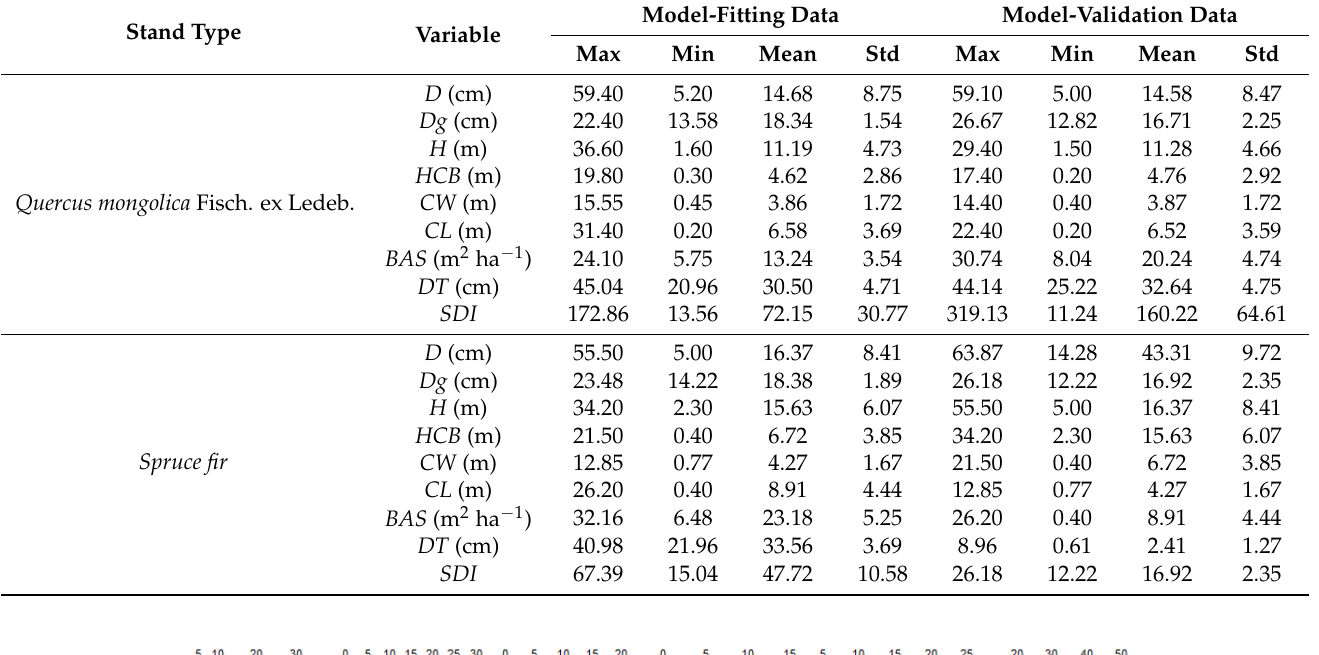
Table 1. Model-fitting and model-validation data (Std: standard deviation; D : diameter at breast